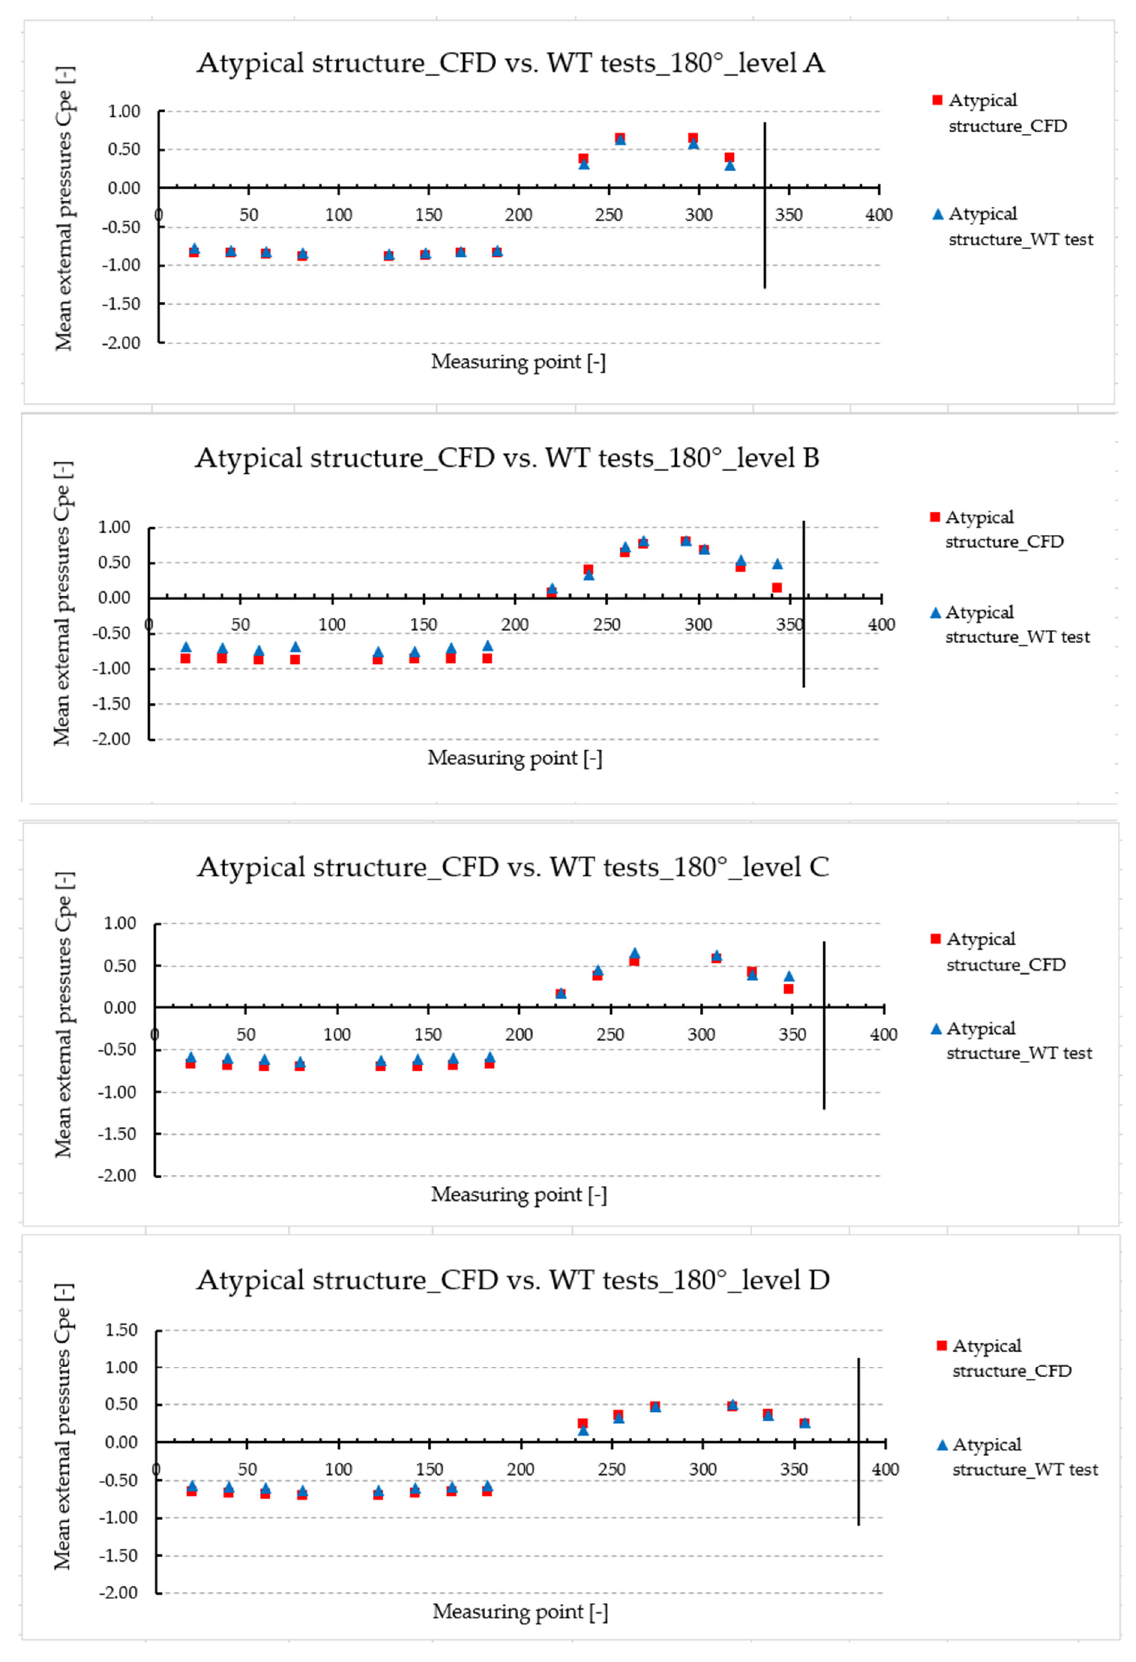
Figure 18. Mean values of c pe determined for the atypical structure—wind direction 180°.